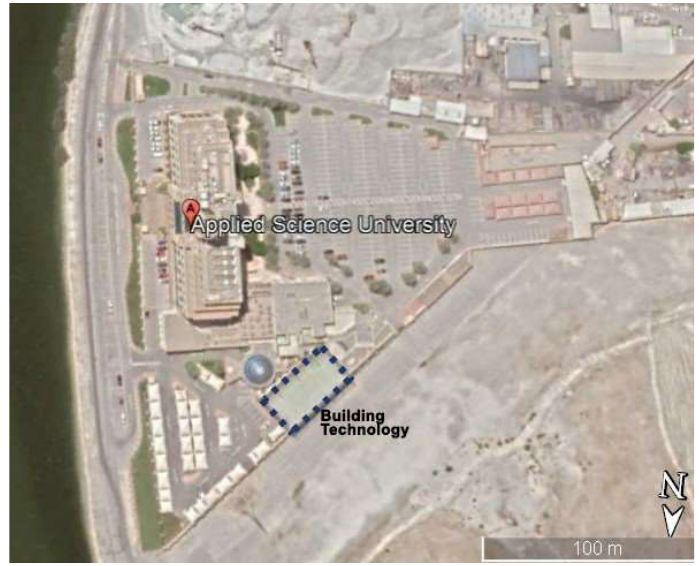
Figure 2. ASU campus, with Building Technology as the case study building.